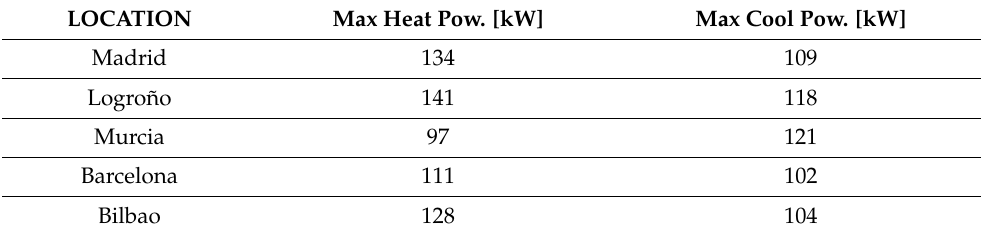
Table 2. Maximum heating and cooling power. LOCATION